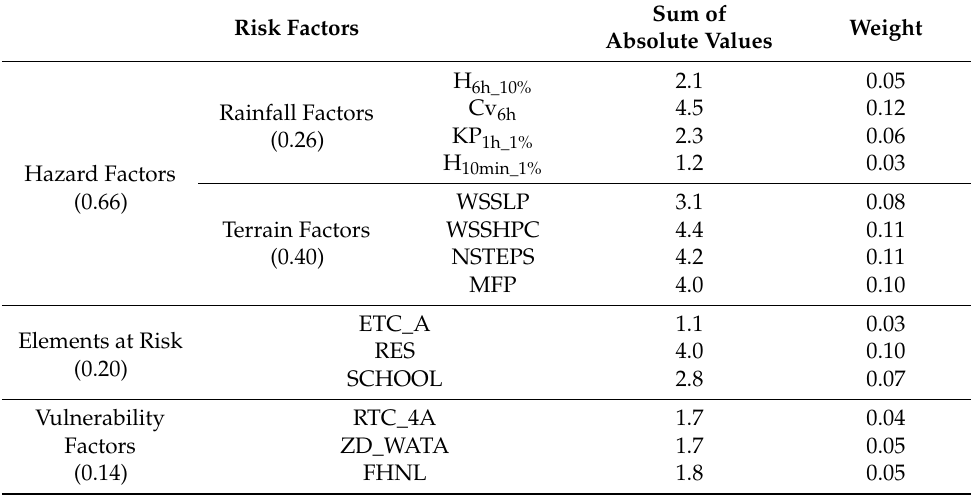
Table 13. Weight of Each Risk